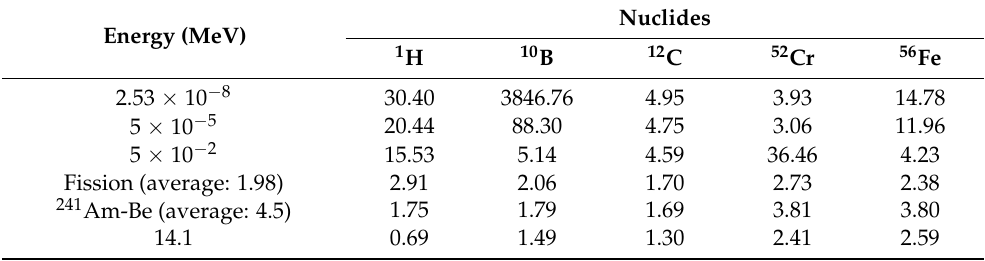
Table 2. The neutron microscopic total cross sections of main nuclides.